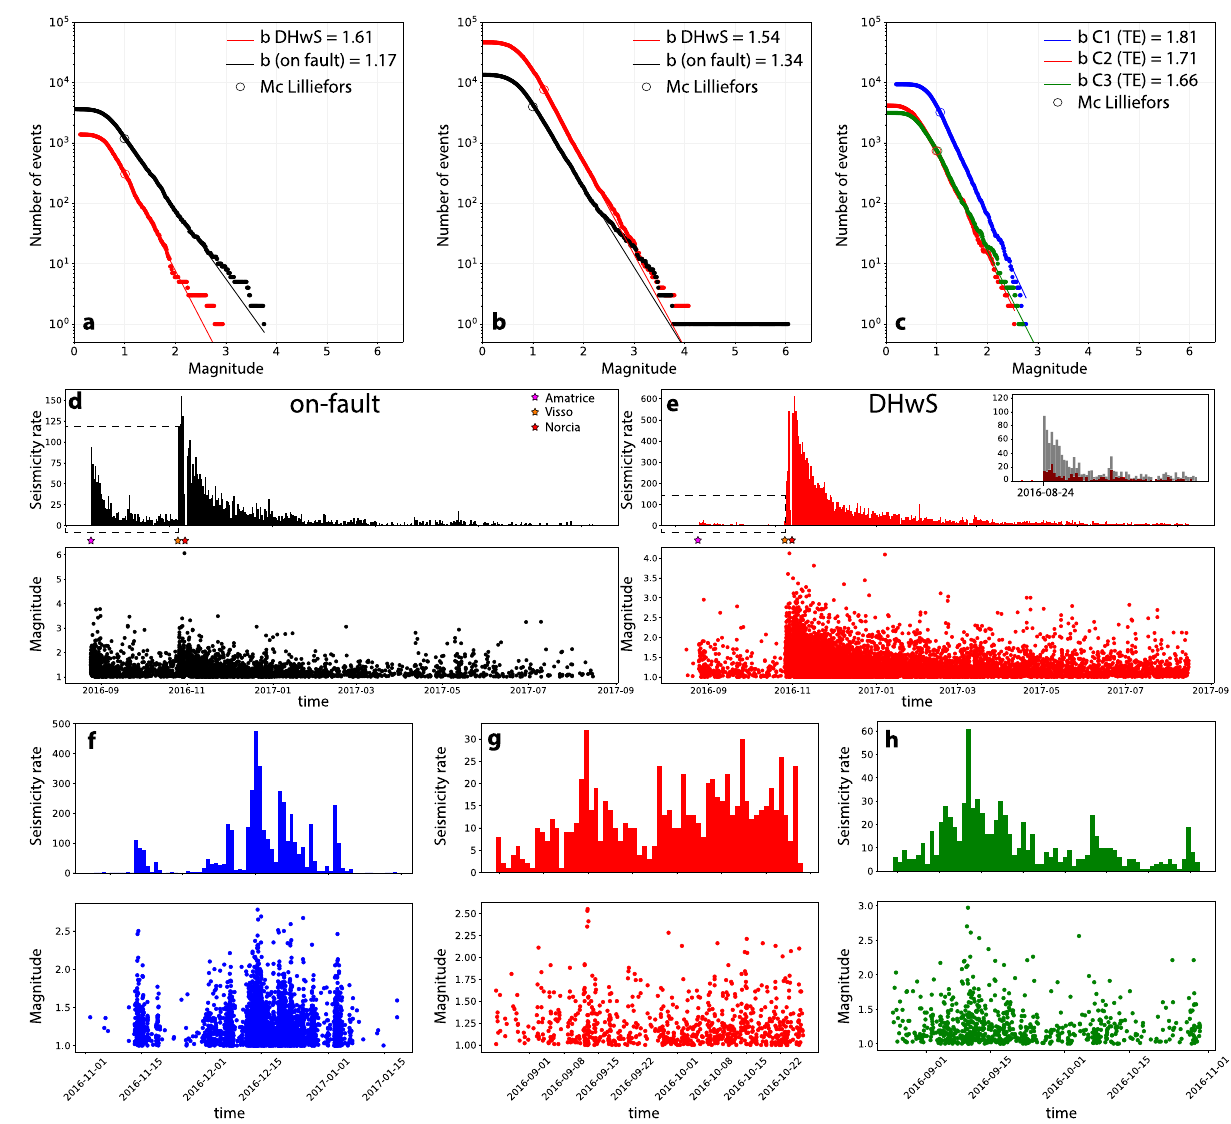
Fig. 3 | On-fault vs. distributed seismicity. a b -values for on-fault vs. down-dip hangingwallseismicity,DHwS,beforethetwomajoreventsofVisso-Norcia,and( b ) fortheentiresequencefrom08/15/2016to08/15/2017. c b -valuesfortheseismicity in clusters C1-C3. d Time evolution of the daily number of earthquakes and